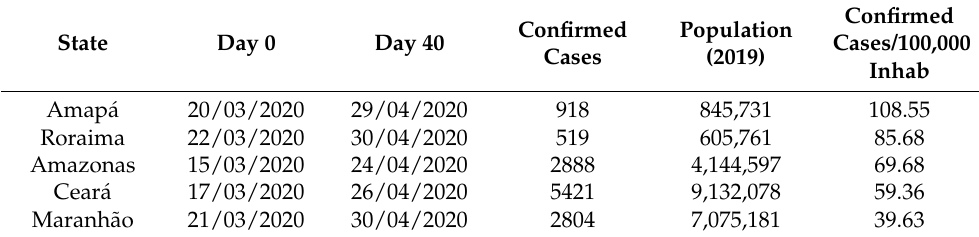
Table 1. Number of confirmed cases per 100,000 inhabitants in the first 40 days of the coronavirus pandemic in the 5 most affected states in Brazil. Source: adapted from data collected from the Brazilian Ministry of Health website [15]. Confirmed State Day 0 Day 40